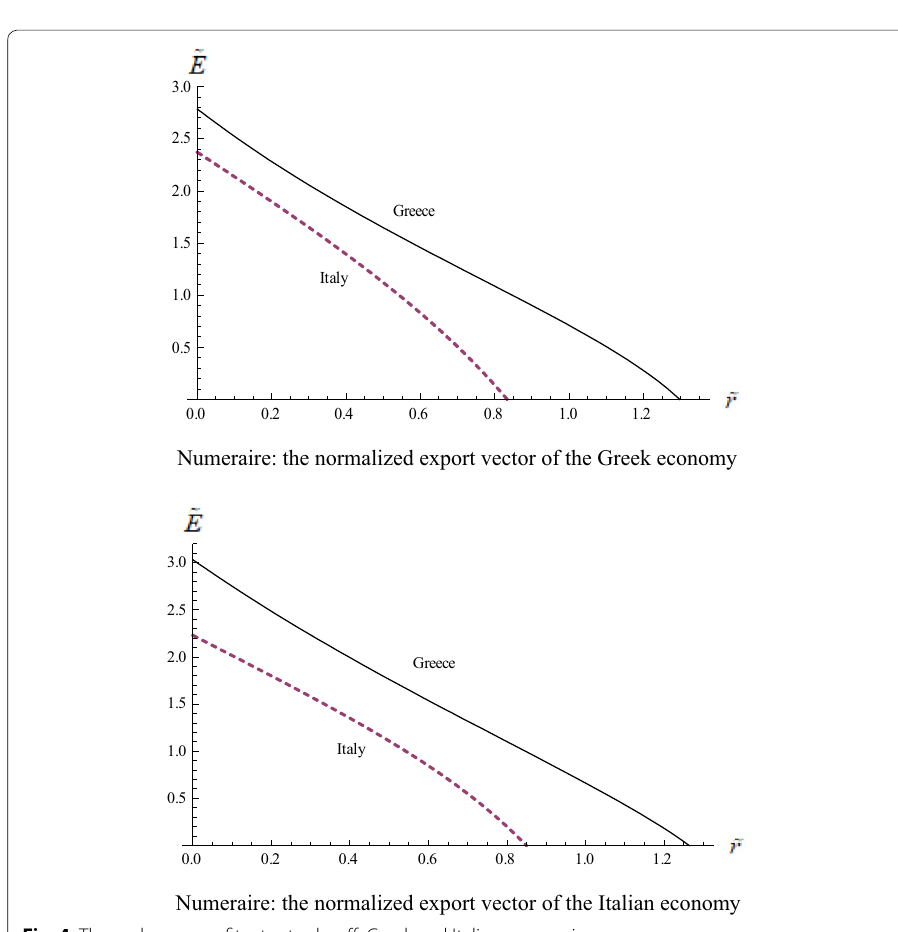
Fig. 4 The exchange-profit rates trade-off; Greek and Italian